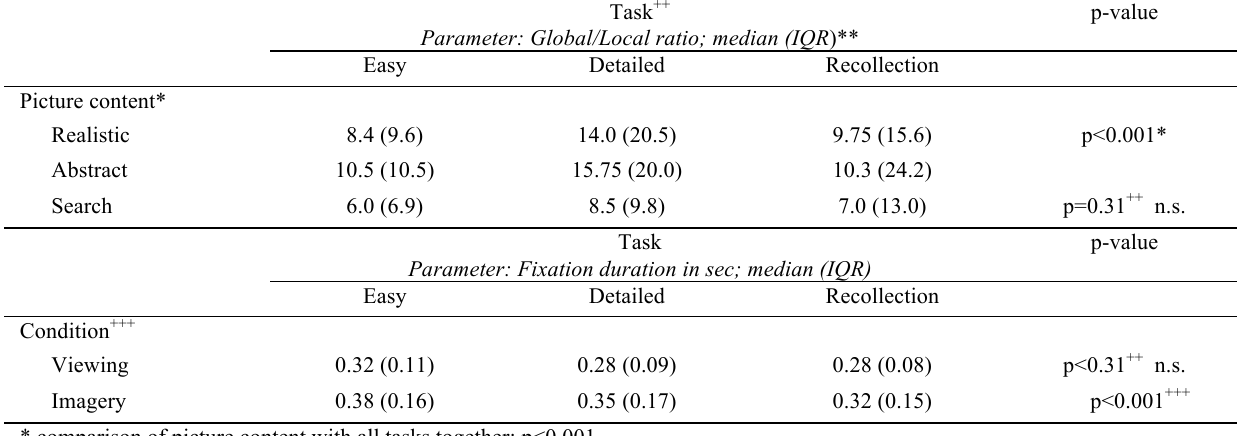
Table 3. Group comparisons of basic scanpath parameters between task and content, and task and condition in SH subjects. Picture content and viewing condition were the main influencing variables. Significant differences were found for comparison of global/local ratio between picture content (realistic, abstract, search), and all tasks together (easy, detailed, recollection); as well as for fixation duration between condition (viewing, imagery) and all tasks together (easy, detailed, recollection). Differences within the task groups (easy, detailed, recollection) were not significant neither for global/local ratio nor for fixation